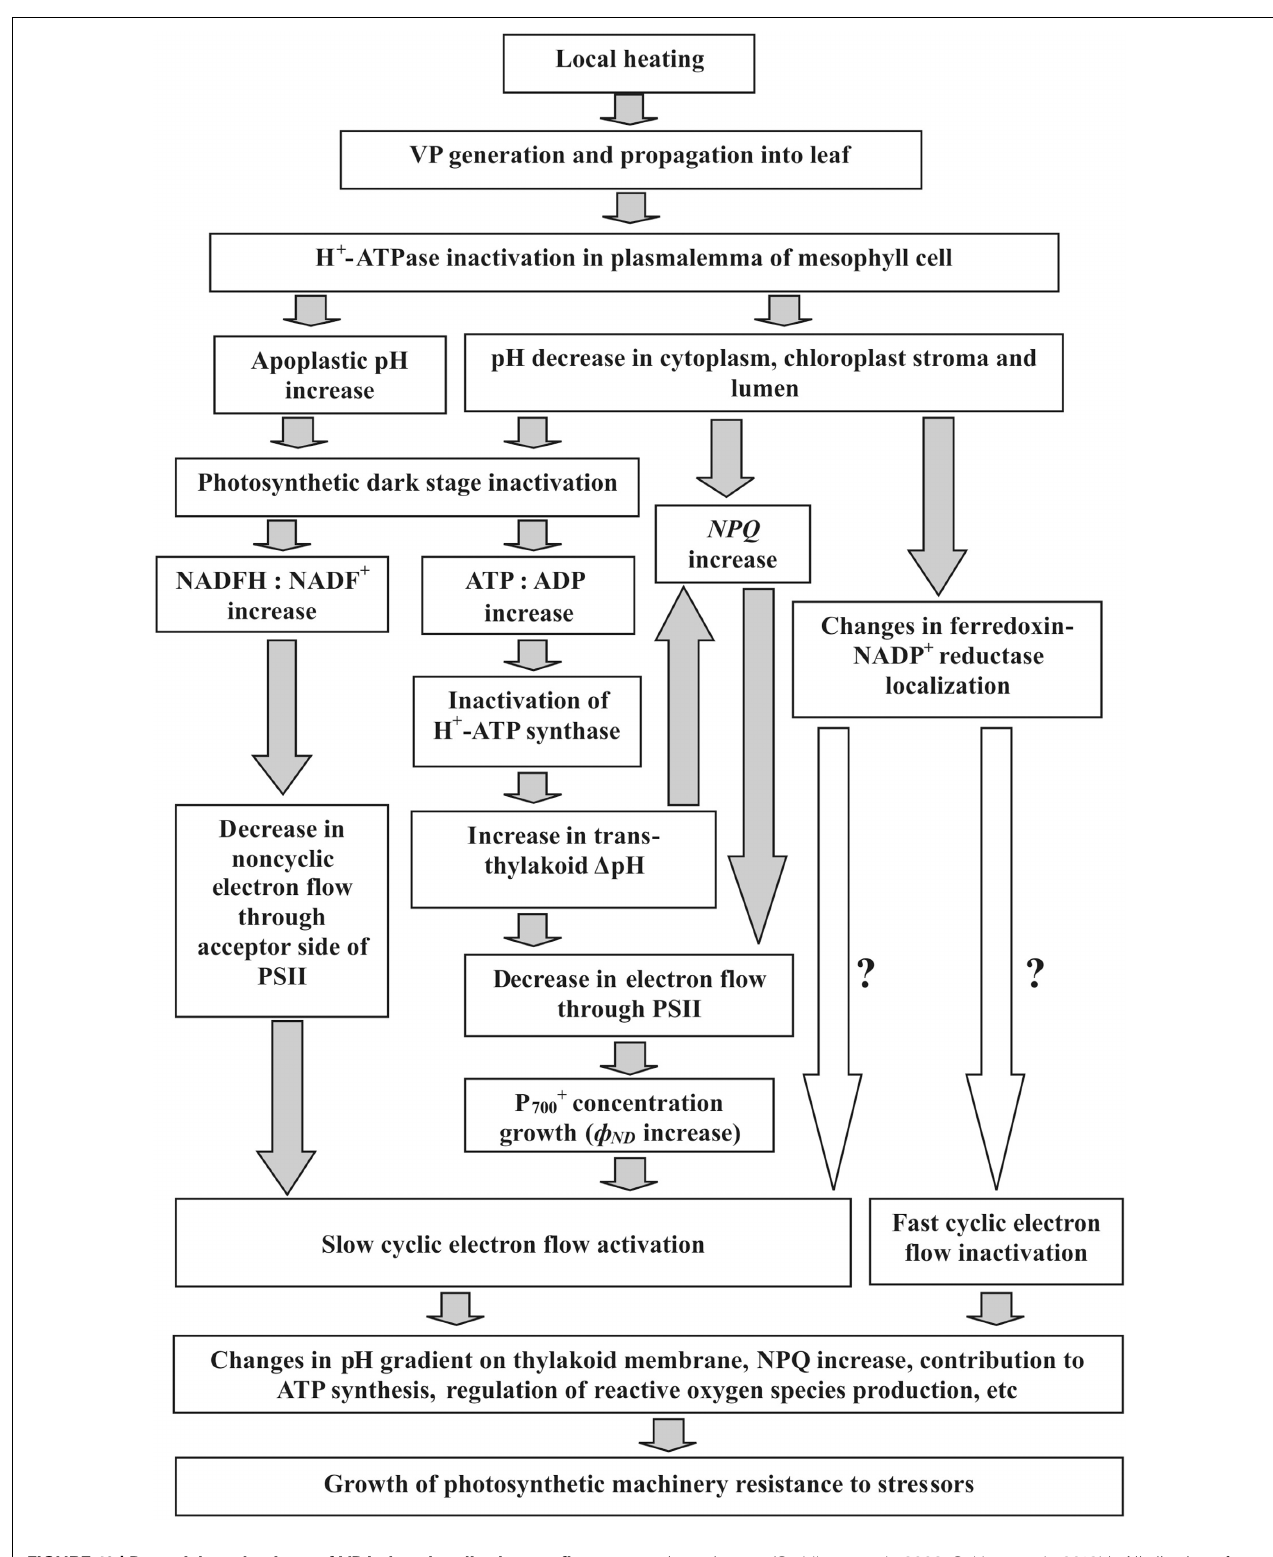
plasmalemma (Stahlberg et al., 2006; Sukhov et al., 2013b). Alkalization of apoplast and acidification of cytoplasm (Grams et al., 2009; Sukhov et al., 2014a) are results of this inactivation. As chloroplast pH strongly depends on